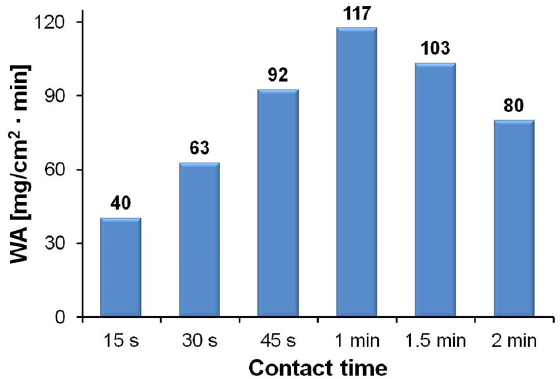
Figure 8. Water absorption measured by the “contact sponge” test on the untreated samples.